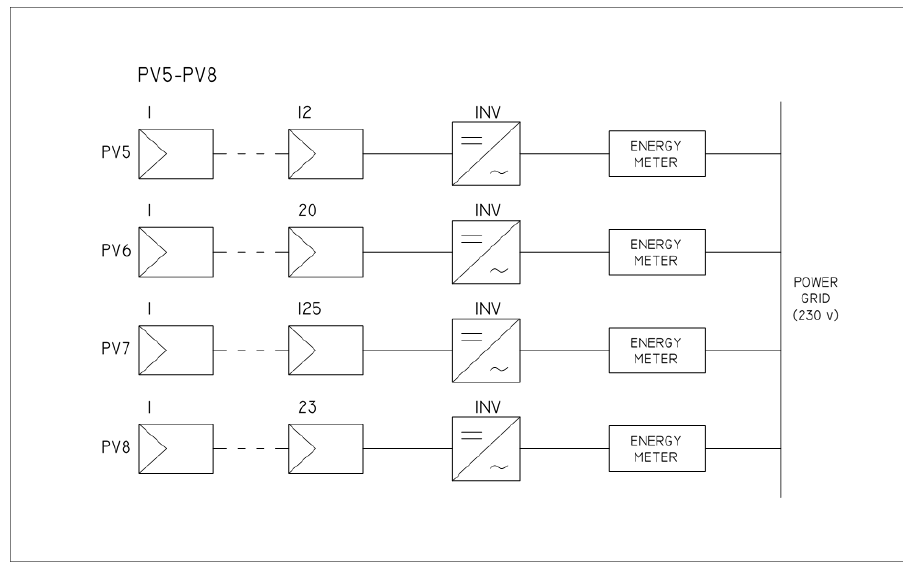
Figure A2. Schematic diagram of PV5–PV8 systems.